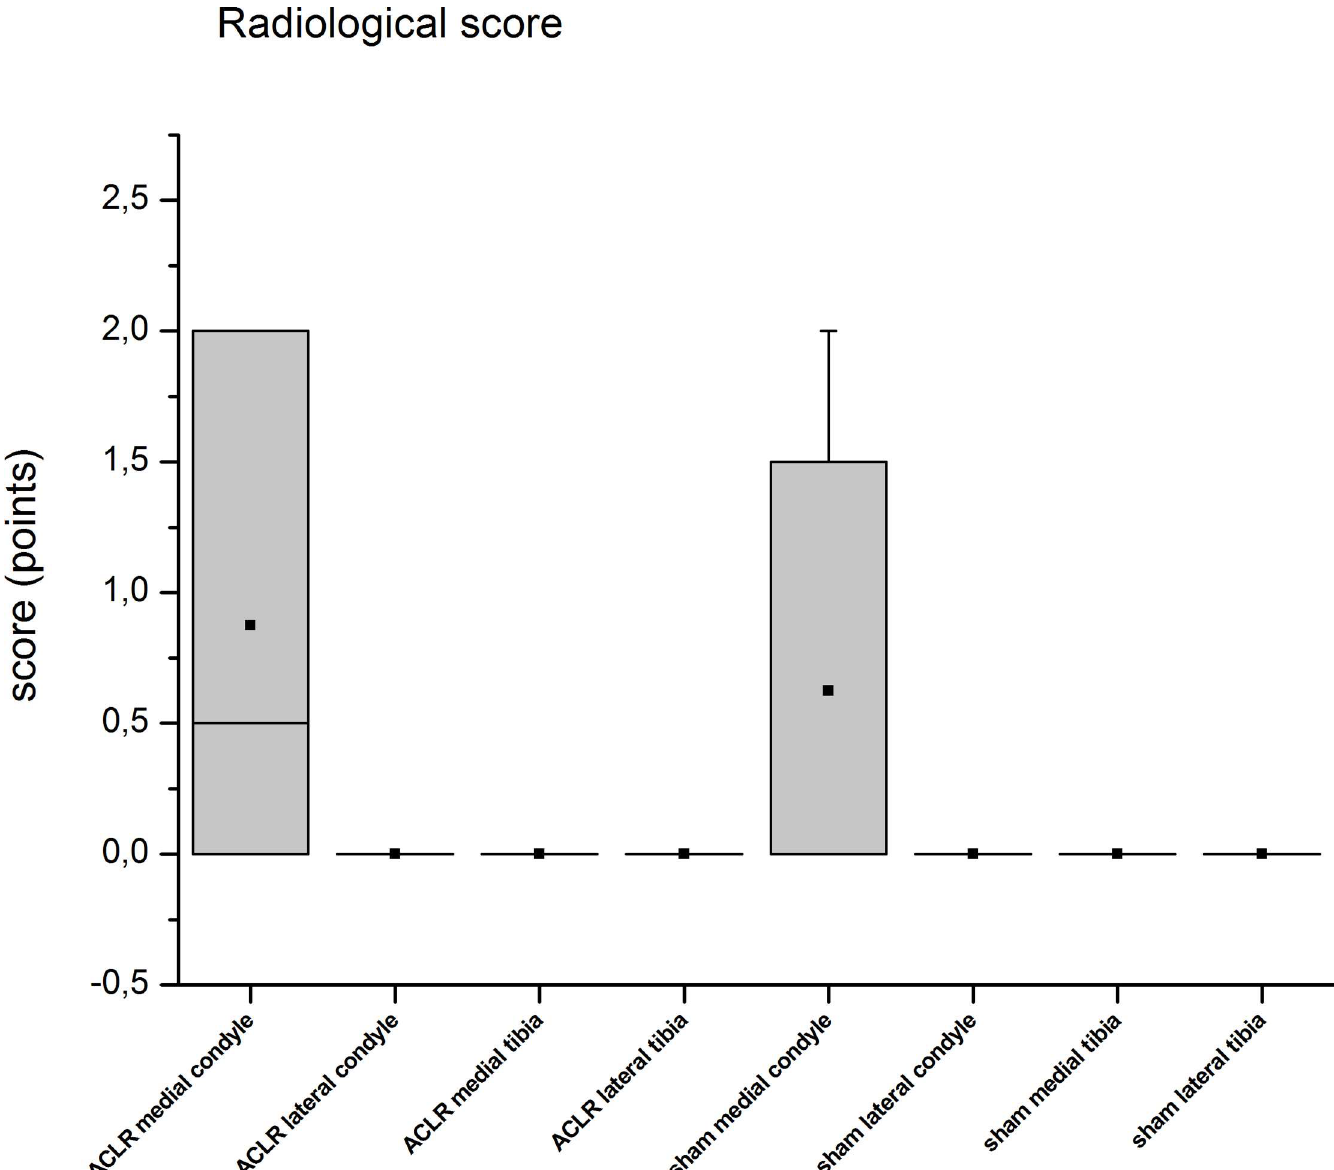
Fig 9. Radiological grading. Radiological grading(from 0 to 4) accordingto the Kellgrenand Lawrence Score [32]. The examinedareas of the ACLR and sham sites showed similar findings in terms of degeneration. This also supported our assumption that the sham-operated knee joints may not qualify as a reliablecontrol group. Another aspect of the x-ray analysis was that only the medialcondyles of the ACLR and sham sites showed changes of any kind. This would indicate that changes would be initially starting in the